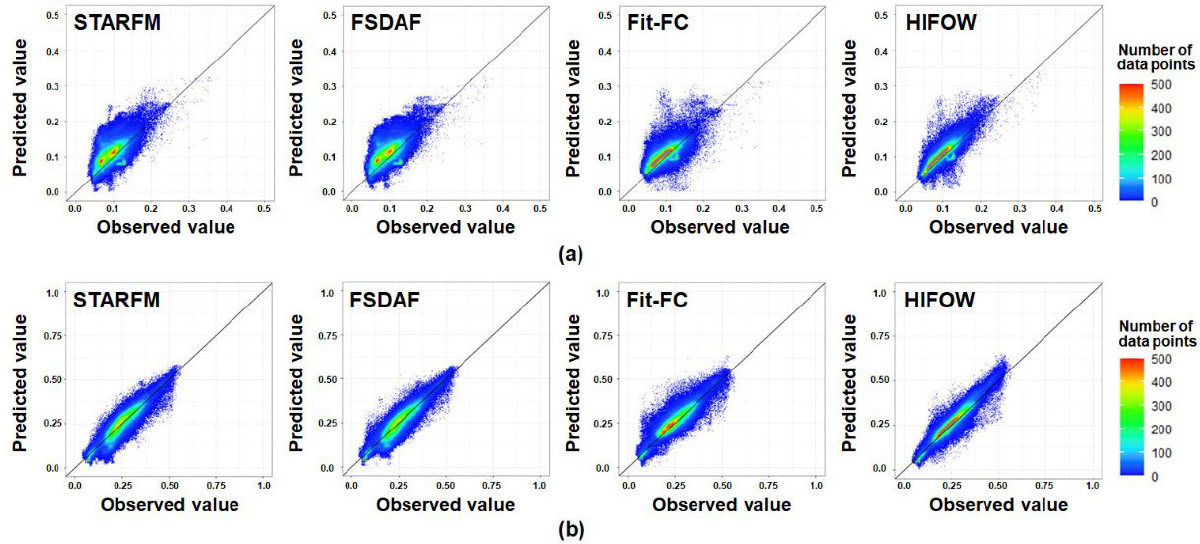
Figure 10. Scatter-density plots of predicted values versus actual values for different STIF models on Site 2: ( a ) red band; ( b ) NIR band.